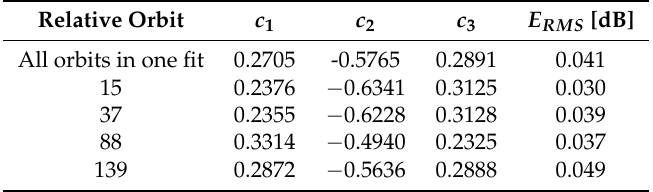
Table 7. Same as Table 6, for the s S 1 of the Sentinel-1 VH